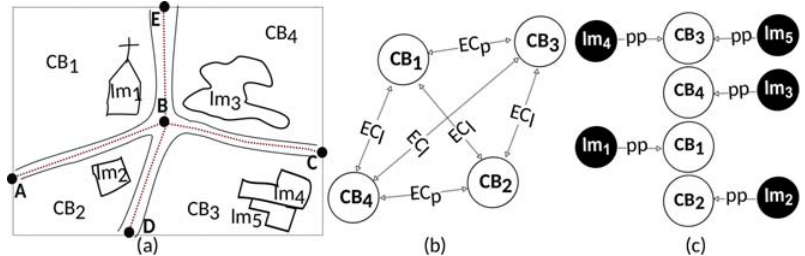
Figure 6: (a) The landmarks and city-blocks in a sketch map, (b) the topological relations between city-blocks using the RCC 11 , and (c) the RCC 5 relation ( proper-part pp ) between landmarks with respect to